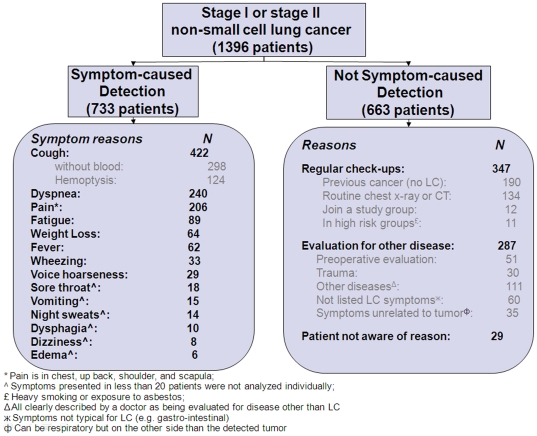
The reasons causing initial medical attention.